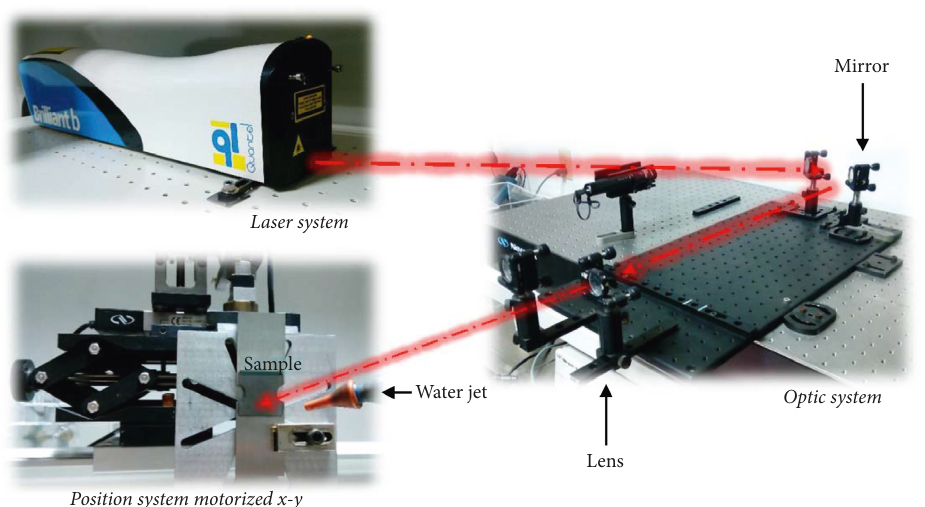
Figure 3: Experimental arrangement of